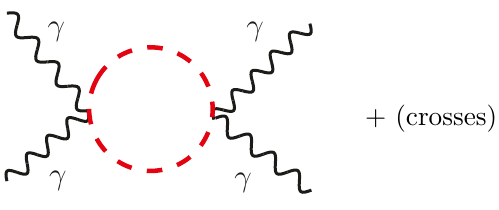
Figure 1 . Four-photon interaction induced by a virtual polarizable dark